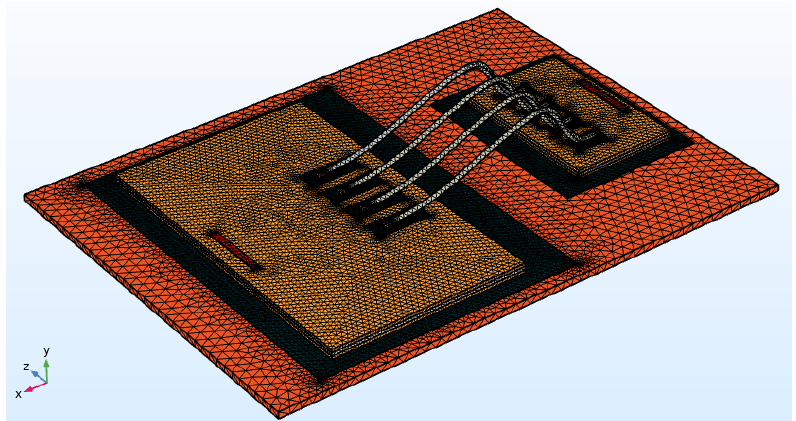
Figure 6. Assigned mesh for the 3D structure of the switch in FEM solutions.